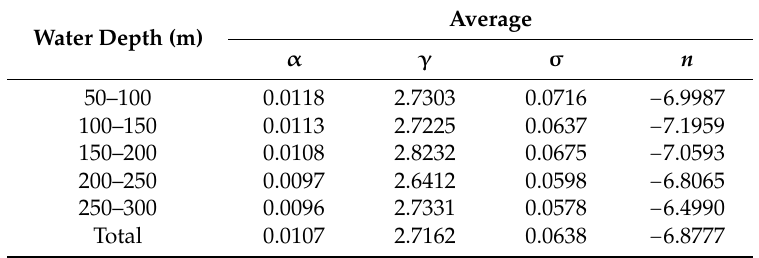
Table 10. JONSWAP parameters under typhoon conditions for different water